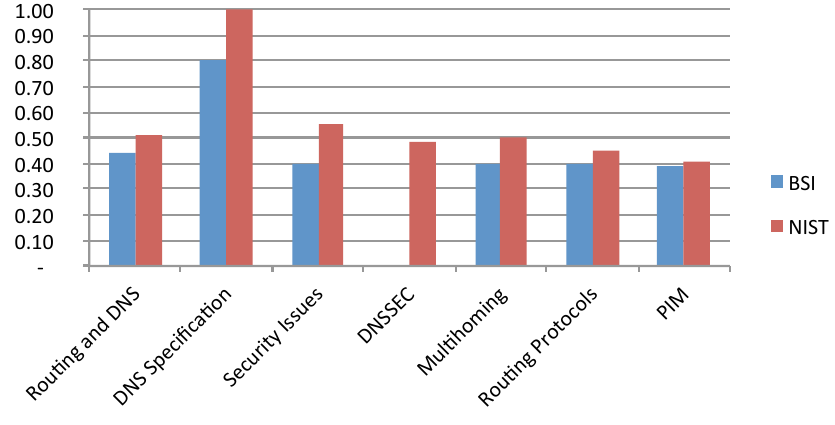
Figure 12. Average depth of routing and Domain Name System